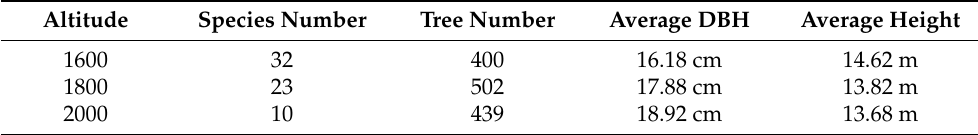
Table 2. Survey information on tree species in sample plots at different